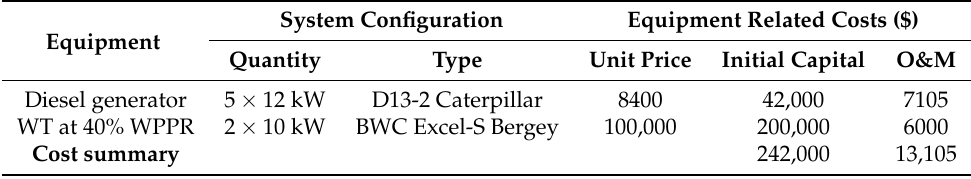
Table 1. Wind–diesel hybrid system configuration and equipment related costs.